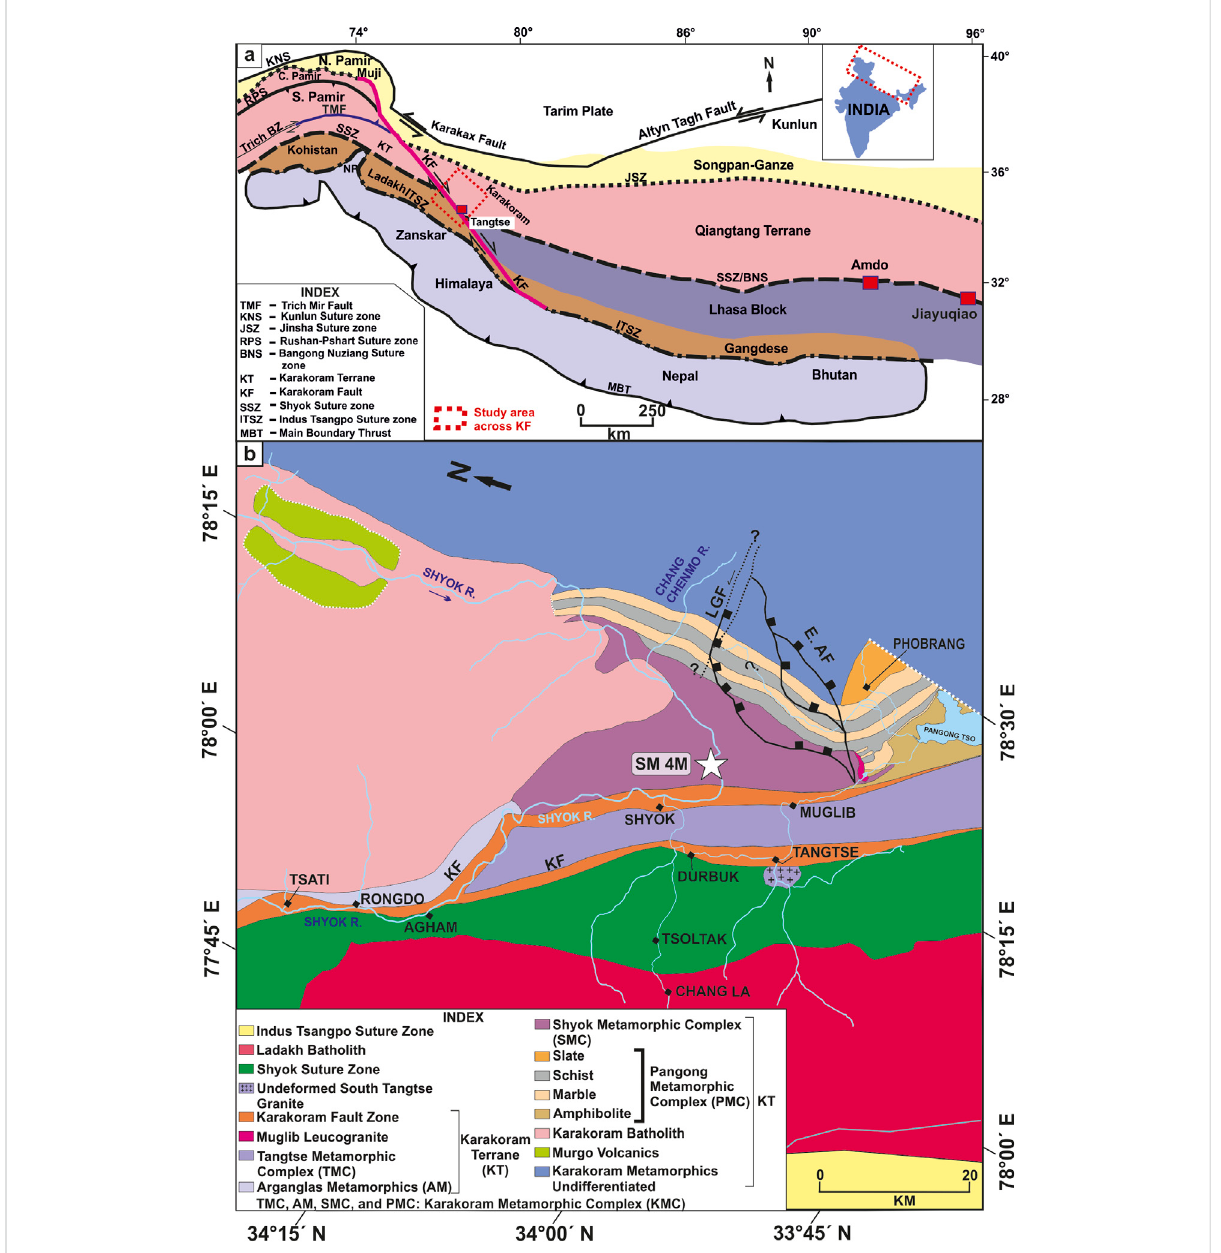
FIGURE 1 (A) Map showing the main tectonic structures and sutures in the Himalaya and Tibet (modi fi ed after Searle, 2011). The red dashed rectangle indicates the map area in Figure 1B. (B) Geological map of the study region (modi fi ed after Jain 2014; Pundir et al., 2020a). LGF: Longmu-Ghoza Co fault; E. AF: East Angmong